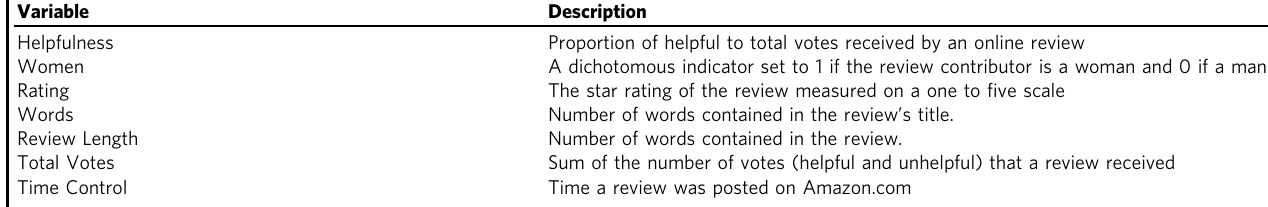
Table 4 Amazon data variables description. Variable